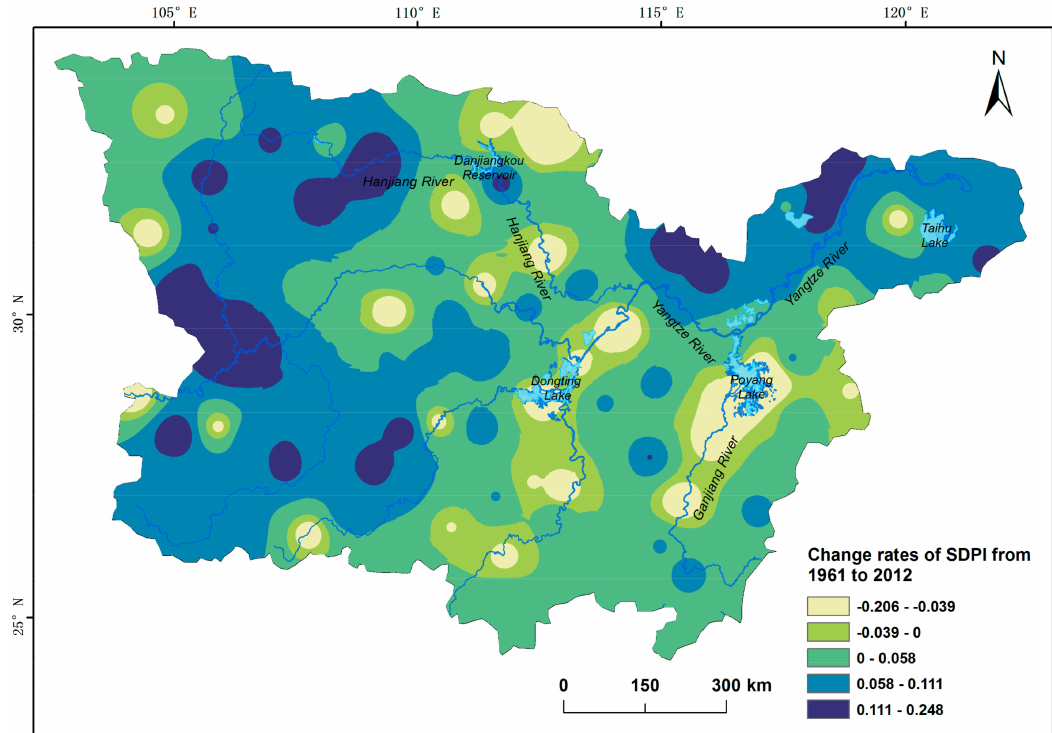
Figure 7. Change rates of the SDPI in the MLR-YR from 1961 to